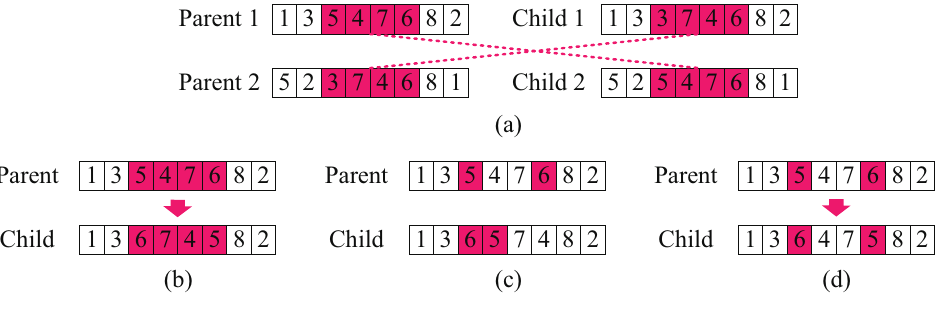
Figure 6. Crossover operation and mutation operation. ( a ) Crossover operator. ( b ) mutation operator—reverse. ( c ) mutation operator—insert. ( d ) mutation